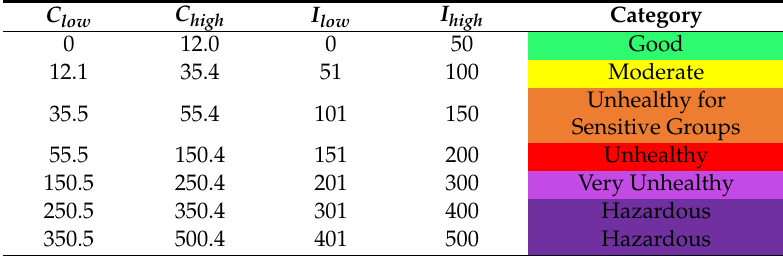
Table 1. Categories and indicators for AQI